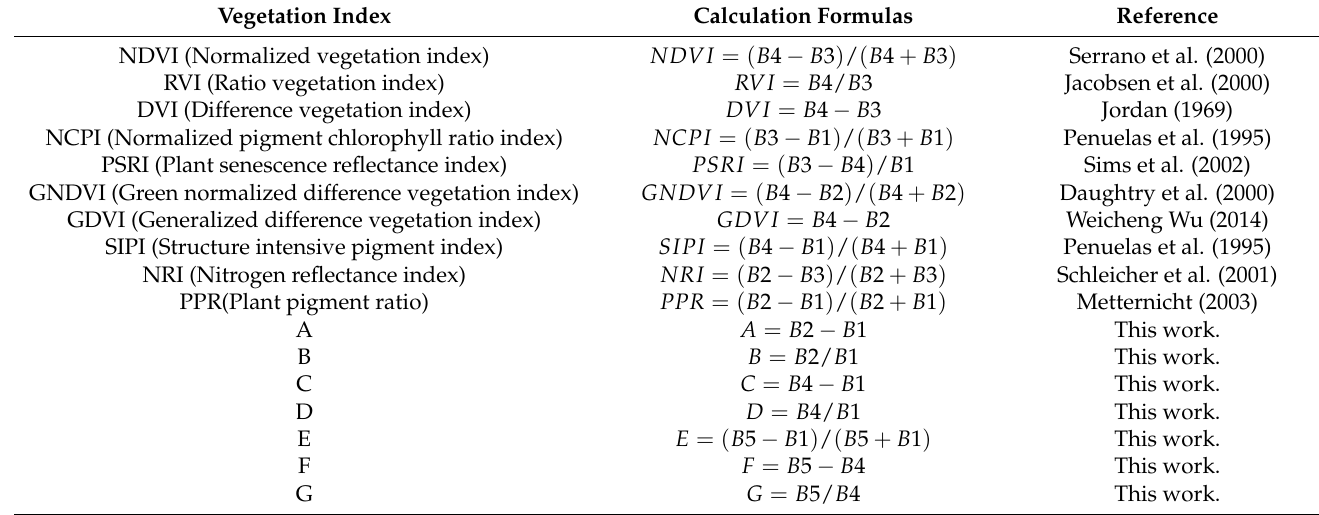
Table 2. Vegetation indexes, formulas, and references used in this